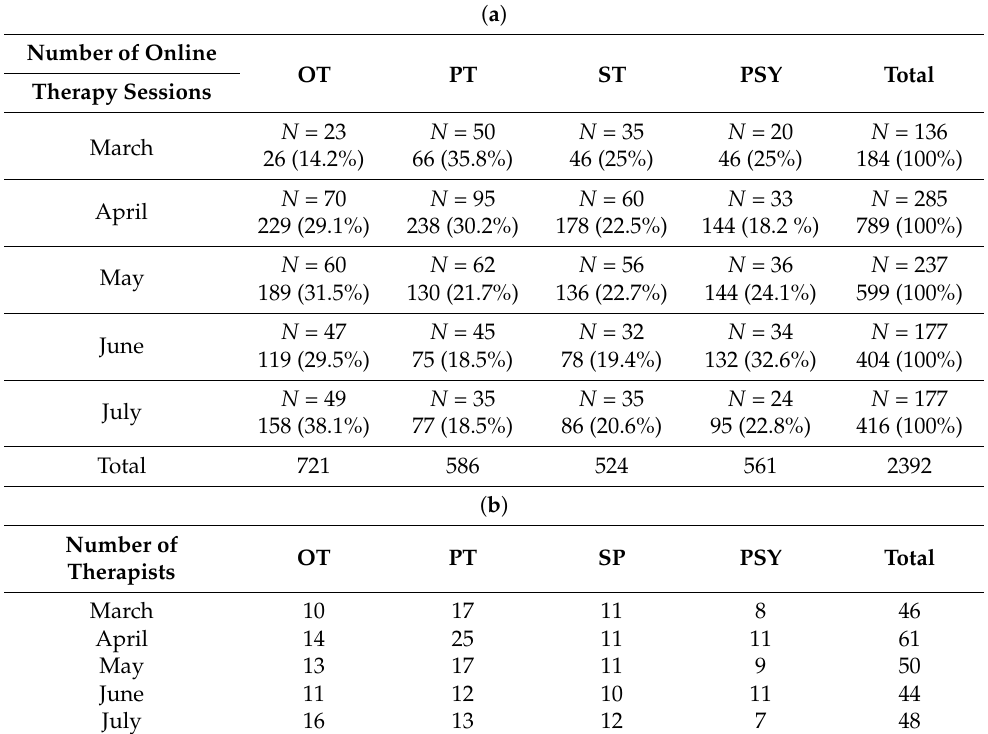
Table 2. ( a ) Number of patients ( n ) that received therapy per discipline and number of online therapy sessions with %. ( b ) Number of therapists that performed online